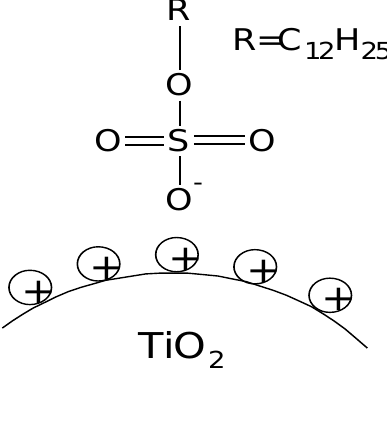
Figure 4. Schematic representation of SDS@TiO